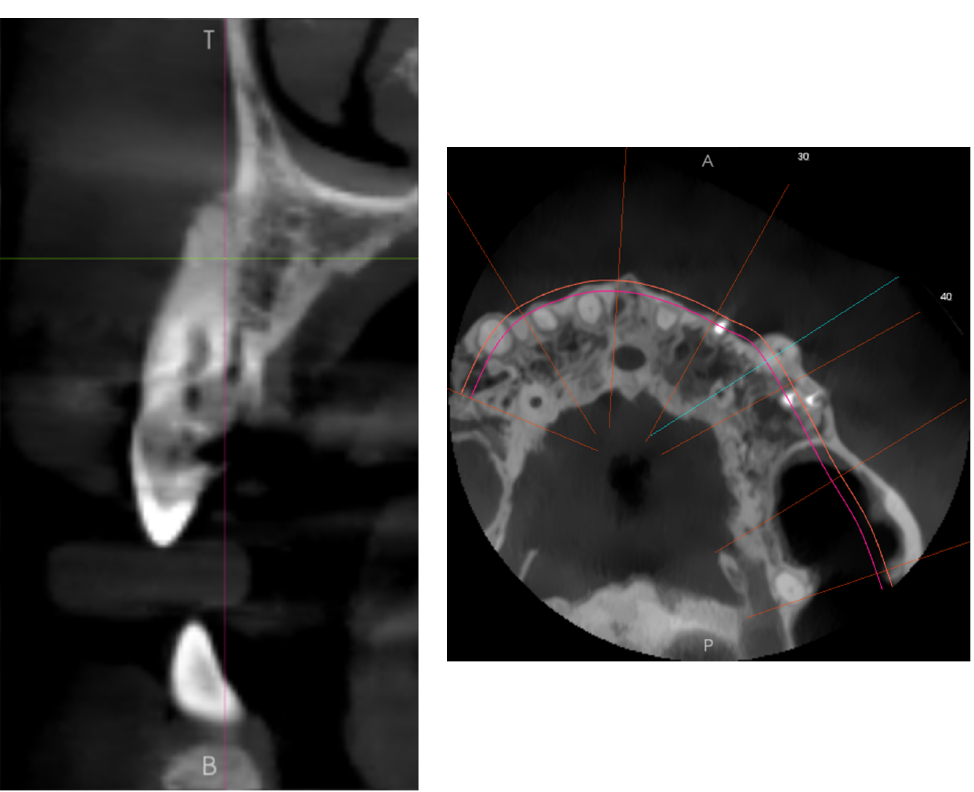
Figure 4. Cross and axial section show apical fenestration of element 23. Foramina was in communi- cation with mucosal tissues.